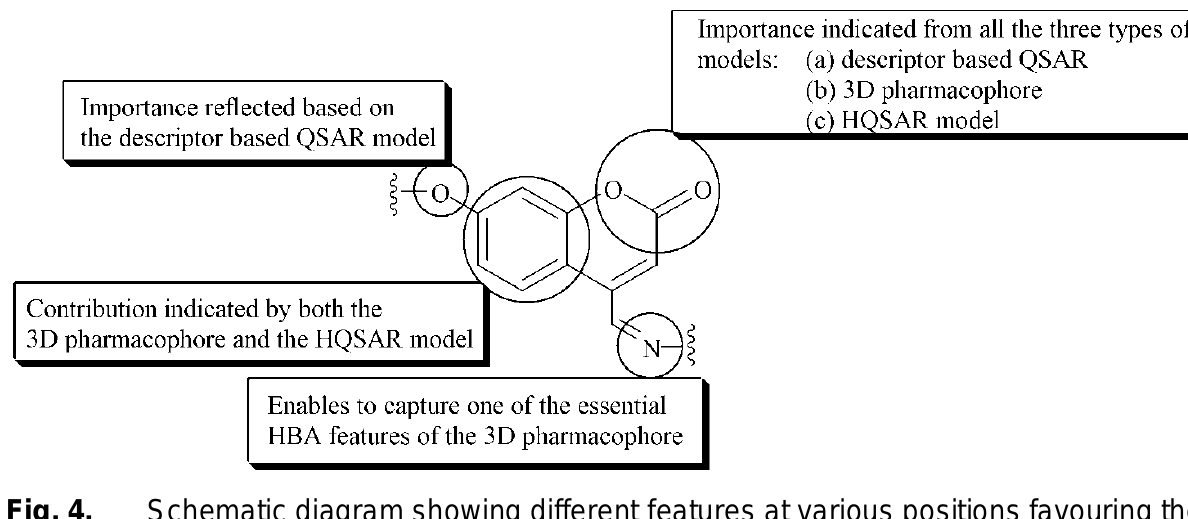
Fig. 4. Schematic diagram showing different features at various positions favouring the antioxidant activity profile of the molecules obtained using different QSAR